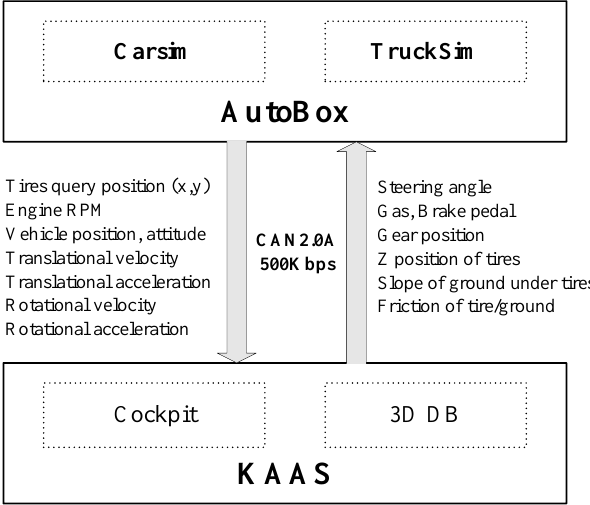
9 of 18 Figure 8. Dimensions of the motion platform. Table 1. Kinematic limit range of the motion platform. Strokes